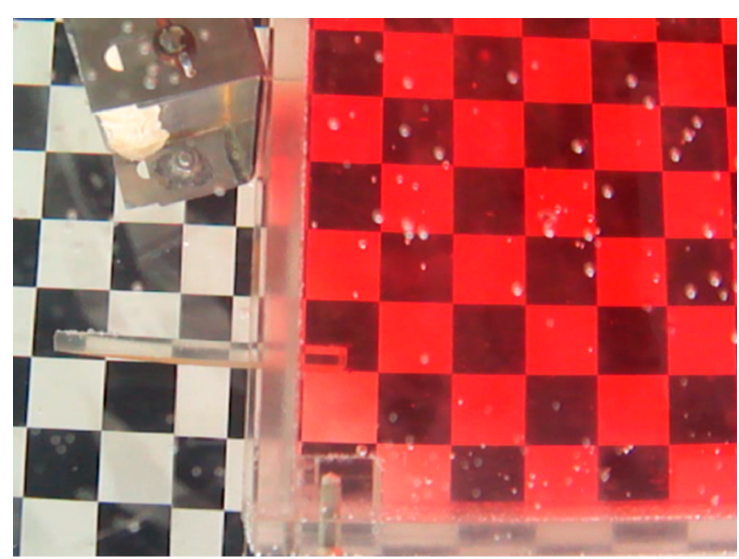
Figure 6. Limit state of the exhaust flow rate.